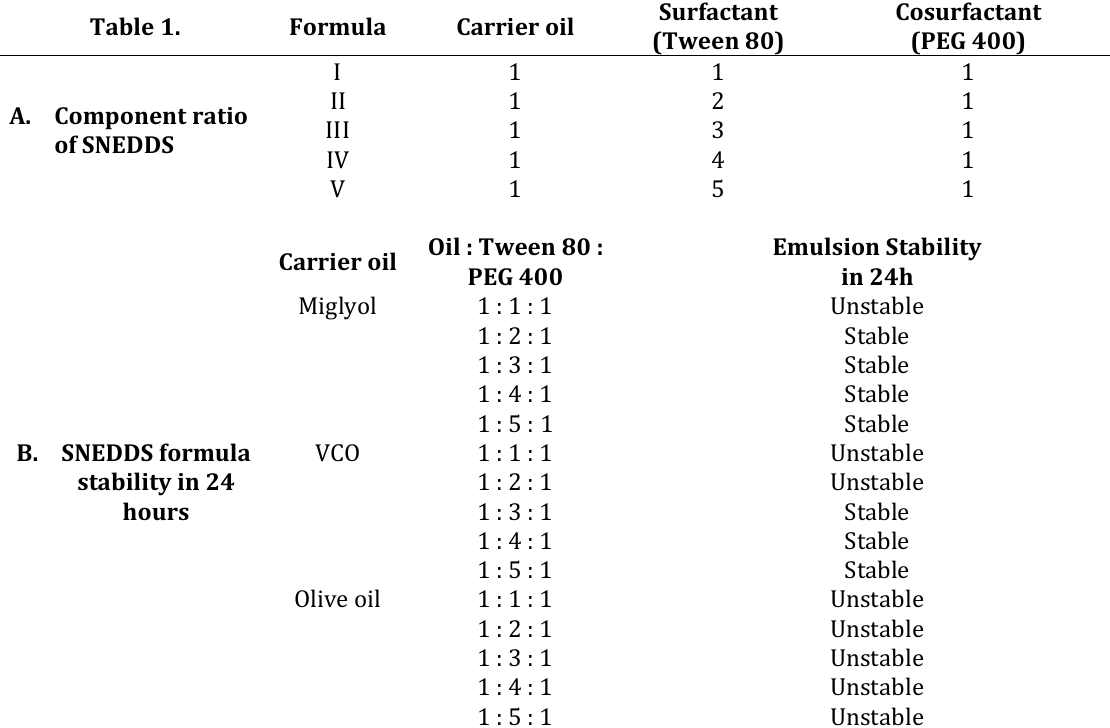
Table I. SNEDDS component ratio and formula stability Table